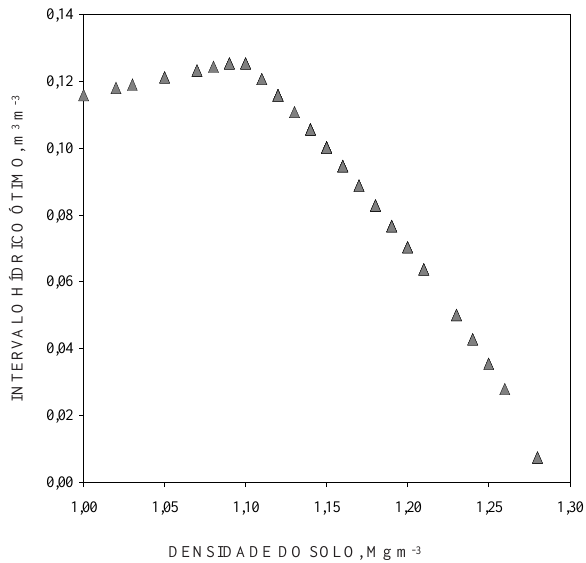
Figura 2. Variação do Intervalo Hídrico Ótimo em função da densidade do